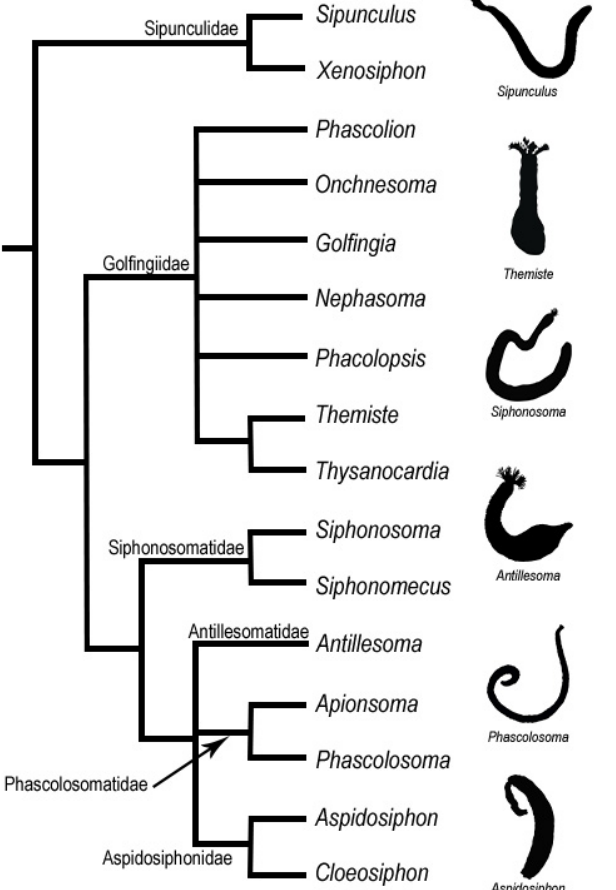
Figure 1. Phylogeny of the Sipuncula (modified from [29]). Right, exemplar shadows representing one genus from each